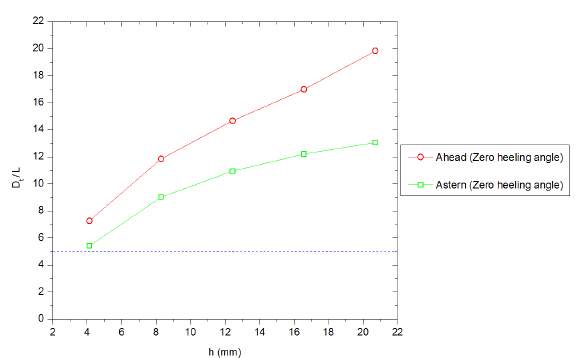
Figure 25: Comparison between the ahead and astern turning circles (power 120%, azimuth angle 35 ◦ ). The simulated turning circle diameter D t is divided by ship length L .